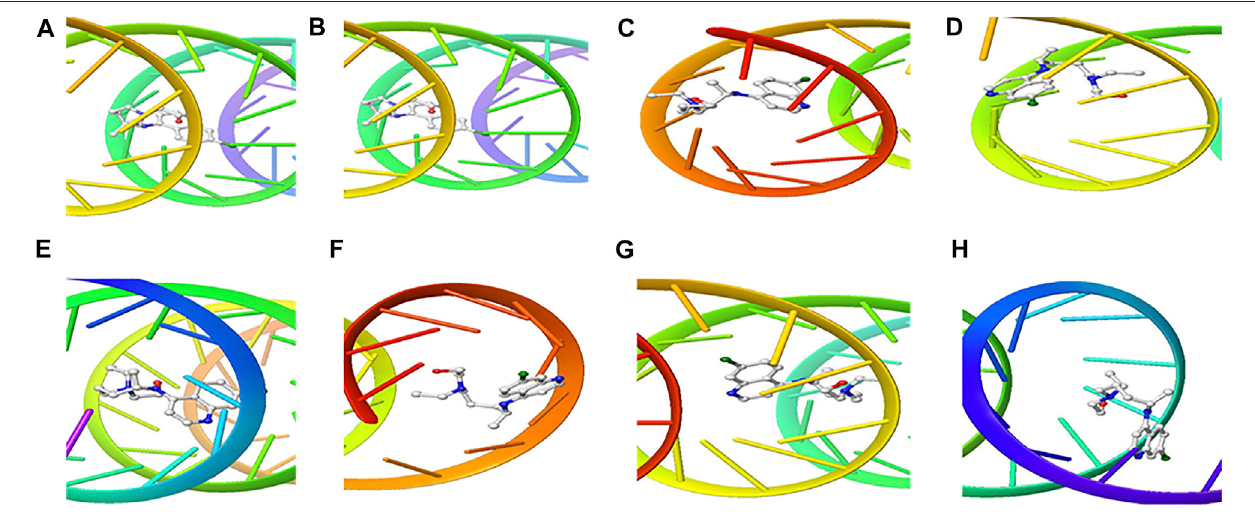
FIGURE 4 | 3D Interaction of hydroxychloroquine with Initiation and Termination Sequence of the Viral Proteins. A (cid:1) Nucleocapsid Phosphoprotein Translation Initiation Site; B (cid:1) Envelope Protein Translation Initiation Site; C (cid:1) Envelope Protein Translation Termination Site; D (cid:1) Nucleocapsid Phosphoprotein Translation